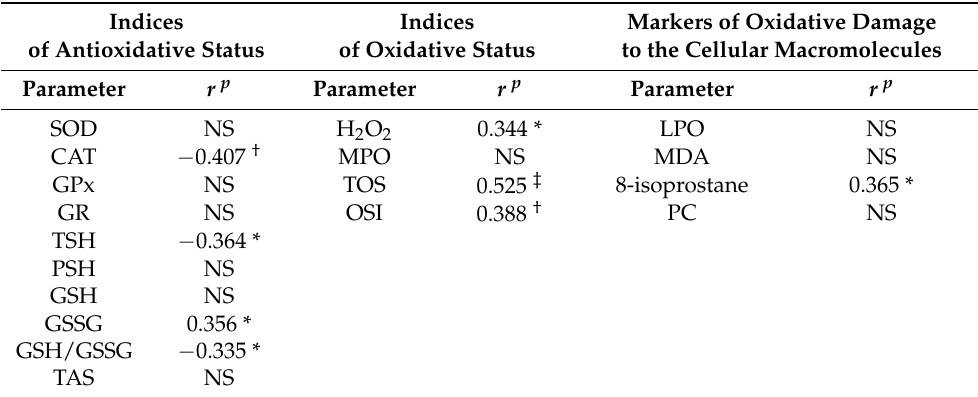
Table 7. Mutual dependencies between cadmium (Cd) concentration in the brain and markers of oxidative/antioxidative status of this organ 1 . Indices Indices Markers of Oxidative Damage of Antioxidative Status of Oxidative Status to the Cellular Macromolecules Parameter r p